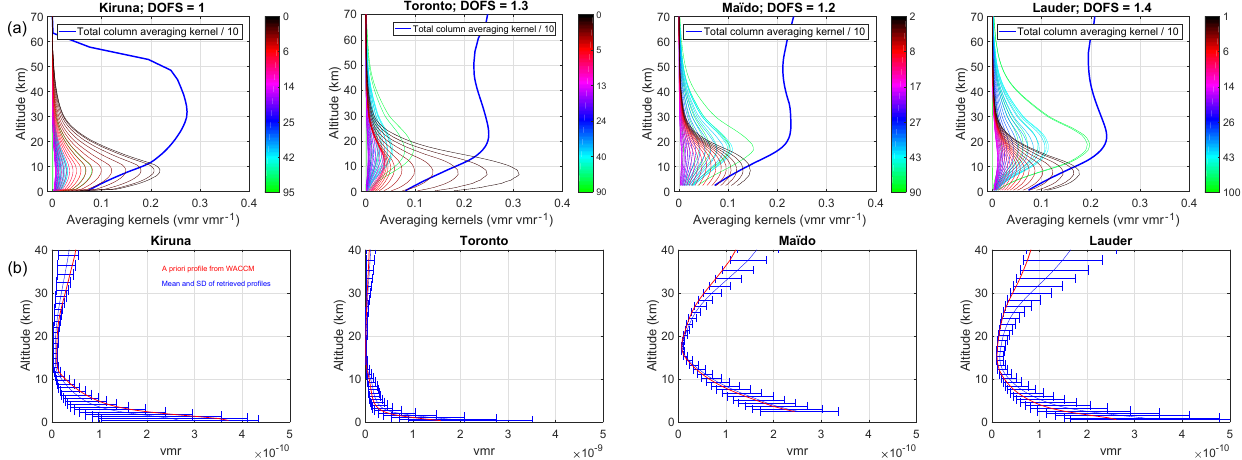
Figure 4. (a) Averaging kernels (rows of A ) and total column averaging kernel for four of the FTIR stations, with DOFS ranging from 1.0 to 1.4. The total column averaging kernel is also shown in a thick blue line (divided by 10 for visibility). The colour code for the different averaging kernels depending on their altitude is given in the colour bar in kilometres. (b) A priori profiles from the WACCM v4 model (red), and the mean and standard deviation of the retrieved profiles for the same four